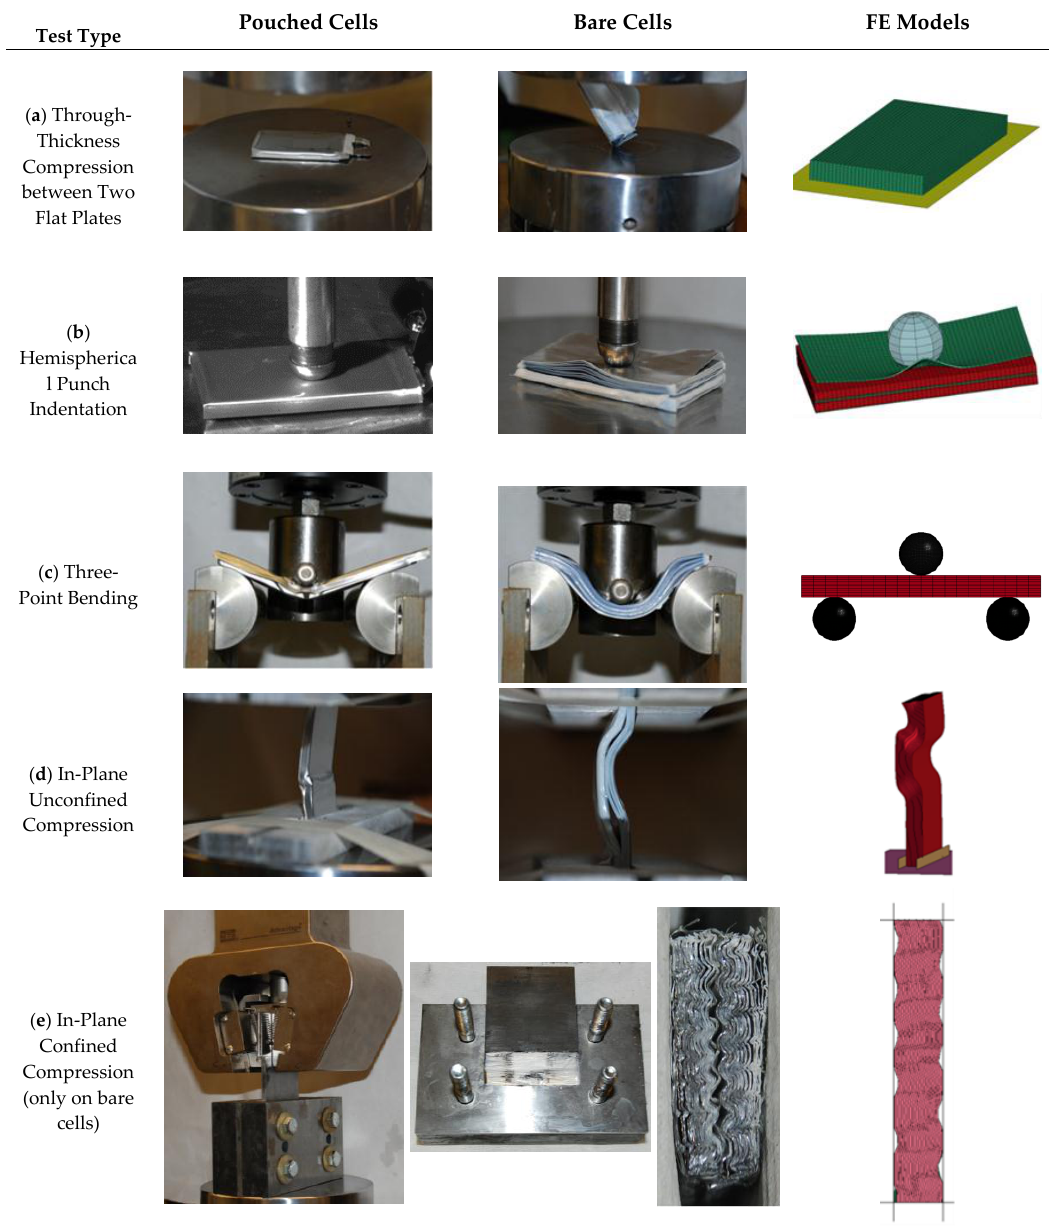
Figure 3. Experimental setup and deformation of pouched ( left ) and bare ( center ) cells. Finite element models are shown in the ( right ) column. Figures are from the study presented in [9].